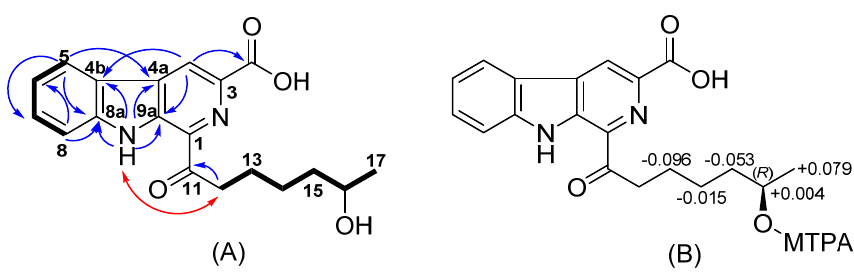
Figure 2. ( A ) Selected COSY (bold bond), NOESY (Nuclear Overhauser Effect Correlation SpectroscopY) red arrow) and HMBC (blue arrows) correlations of compound 4 . (B) Shielding effect of MTPA moiety of 4 , Δ S-R values are